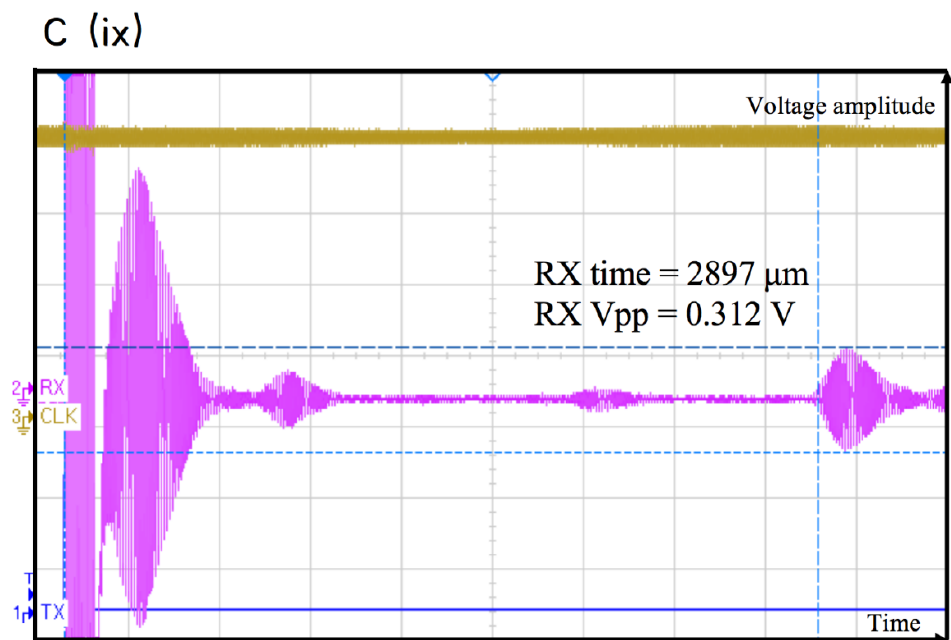
Figure 6. Measuring setup and results of ranging system. ( a ) The setup for range measurement (100–500 mm). ( b ) Power consumption of the chip in different working modes. ( c ) The experimental results of measuring waveforms. The distance from ( i ) to ( ix ) is from 10 cm to 50 cm in the increment of 5 cm. Table 1. The results of the ranging (100 mm–500 mm).